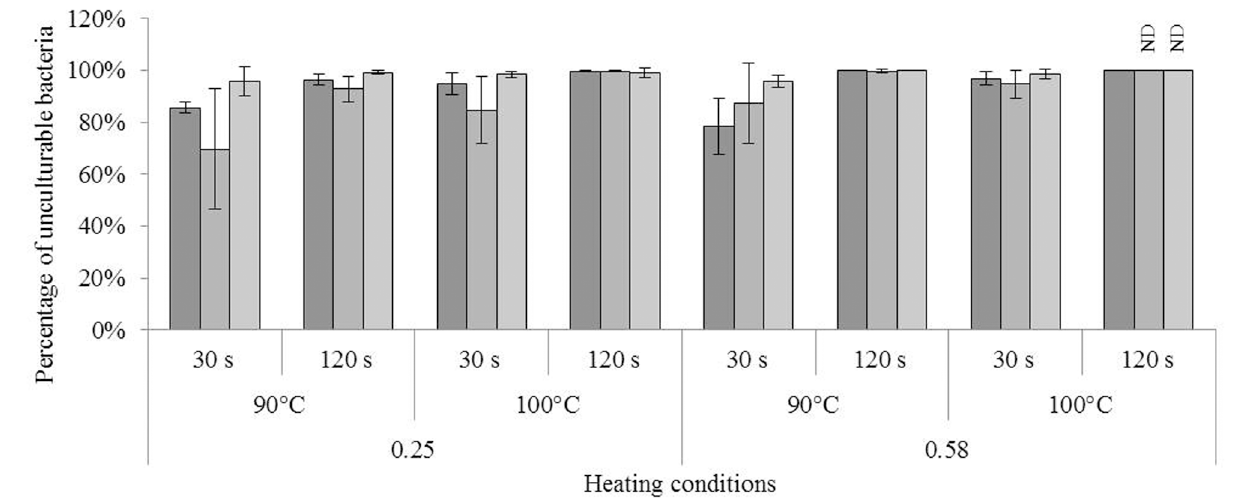
FIGURE 4 | Impact of heating in dried state on culturability of Cronobacter sakazakii , Salmonella Typhimurium, and Salmonella Senftenberg cells. Impact of heat treatment on culturability of each species; from darker to lighter, bars represent the percentages of unculturable C. sakazakii , S. Typhimurium, and S. Senftenberg cells as a function of the heating conditions, namely the water activity of the milk powder (0.25 or 0.58), heating temperature (90 or 100 ◦ C), and time of treatment (30 or 120 s). The equivalent logarithmic inactivation is indicated above each bar. Error bars represent the standard deviation obtained using independent triplicates. The corresponding logarithmic inactivation numbers are presented in Supplementary Table S1